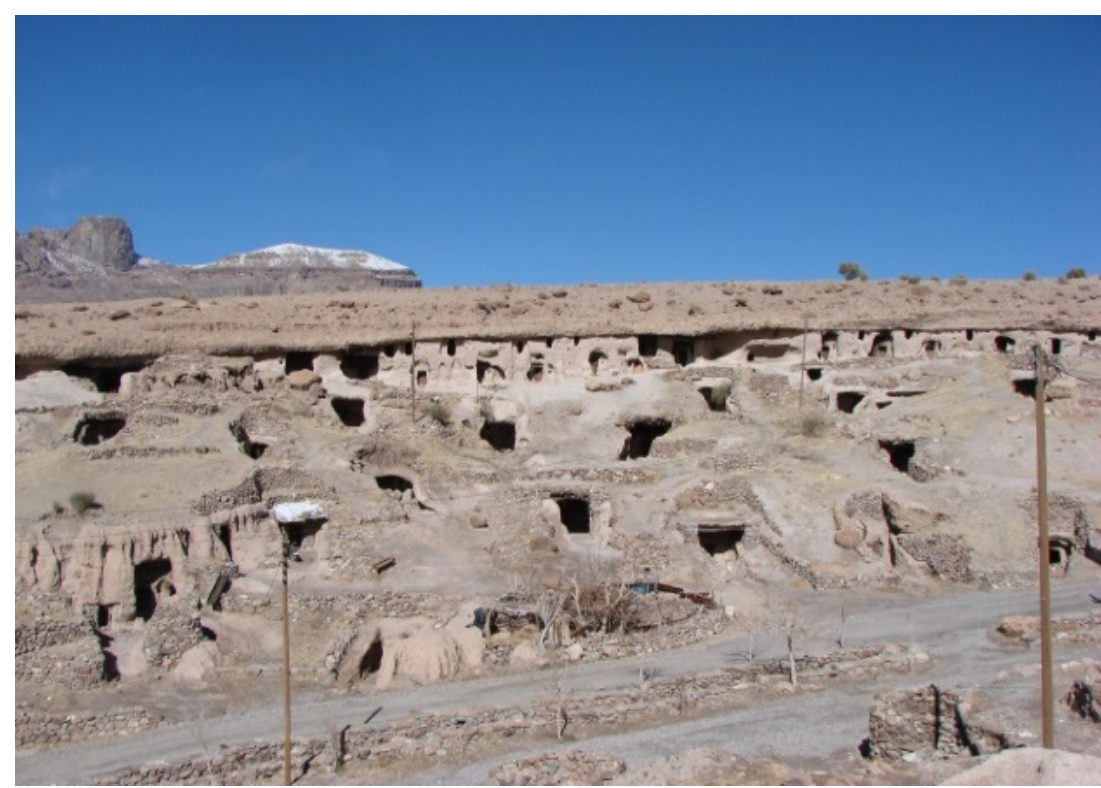
Figure 5. Eastern view of Meymand village.